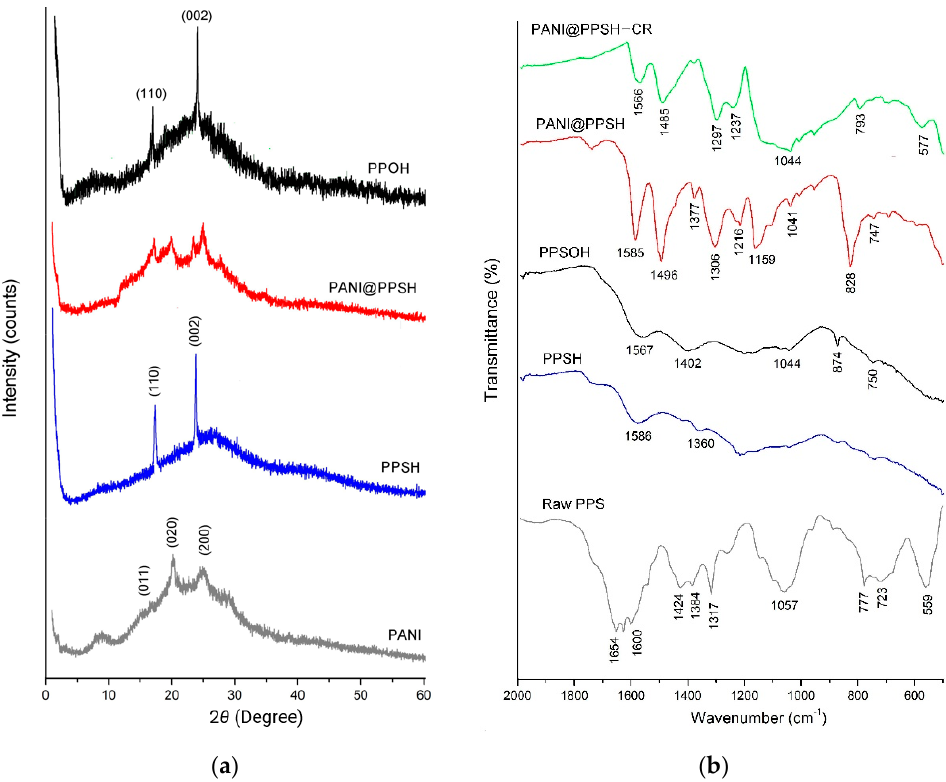
Figure 1. ( a ) X-ray diffraction (XRD) patterns and ( b ) Fourier-transform infrared spectroscopy (FT-IR) spectrum (before and after adsorption) of samples.